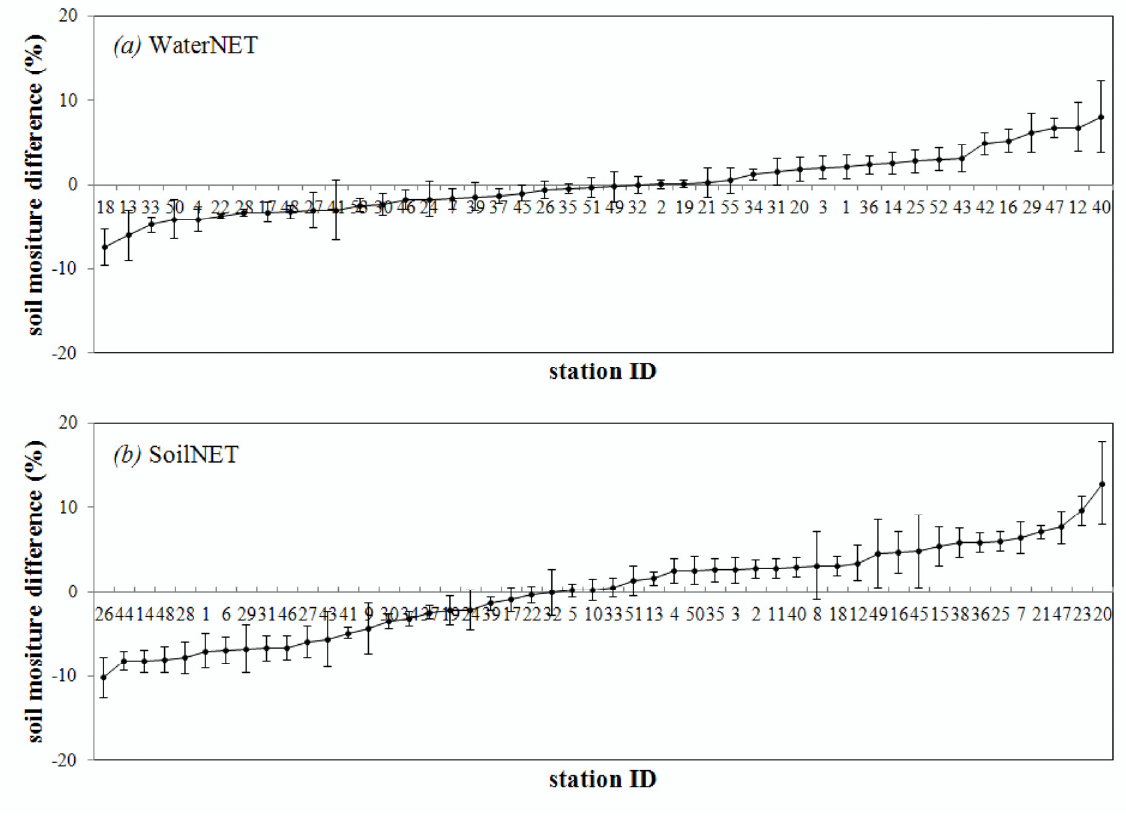
Figure 8. Rank ordered mean relative differences with standard deviation (vertical bar) for the soil moisture monitoring campaigns carried out for: ( a ) WaterNET and ( b )